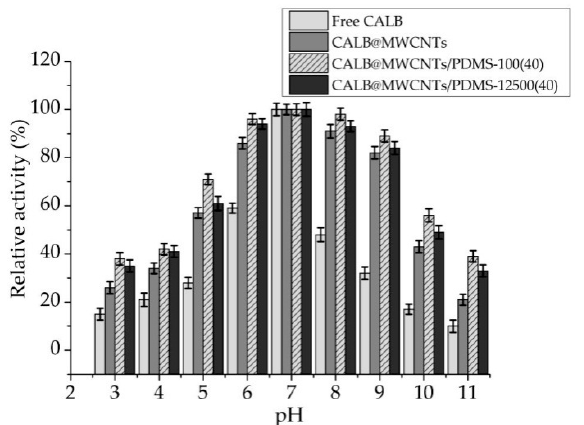
Figure 4. pH profiles of free lipase and enzymeimmobilized onto P-MWCNTs and MWCNTs/PDMS nanocomposites.